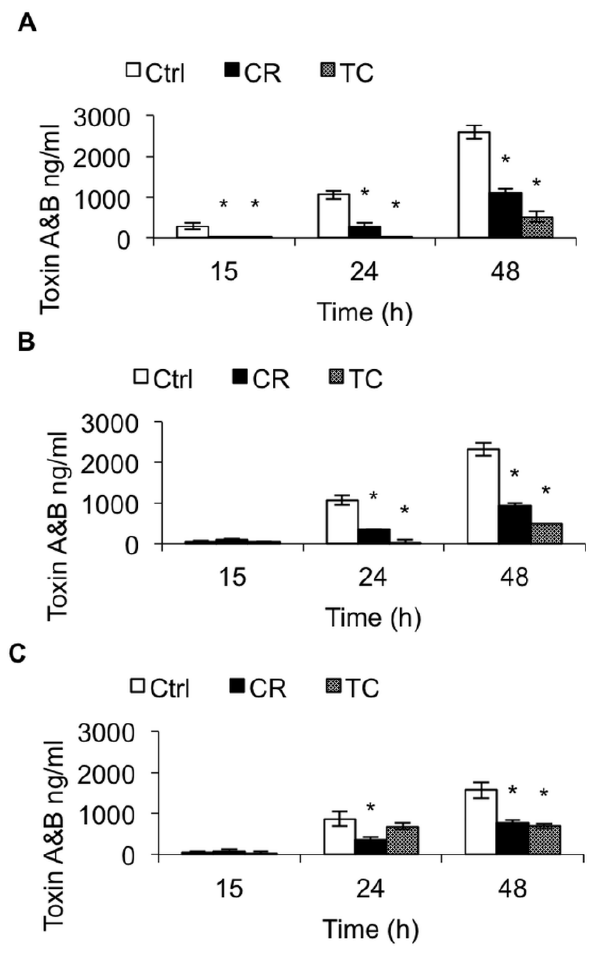
Figure 2. Effect of carvacrol (CR) and trans -cinnamaldehyde (TC) on C. difficile toxin production. * p < 0.05 vs.